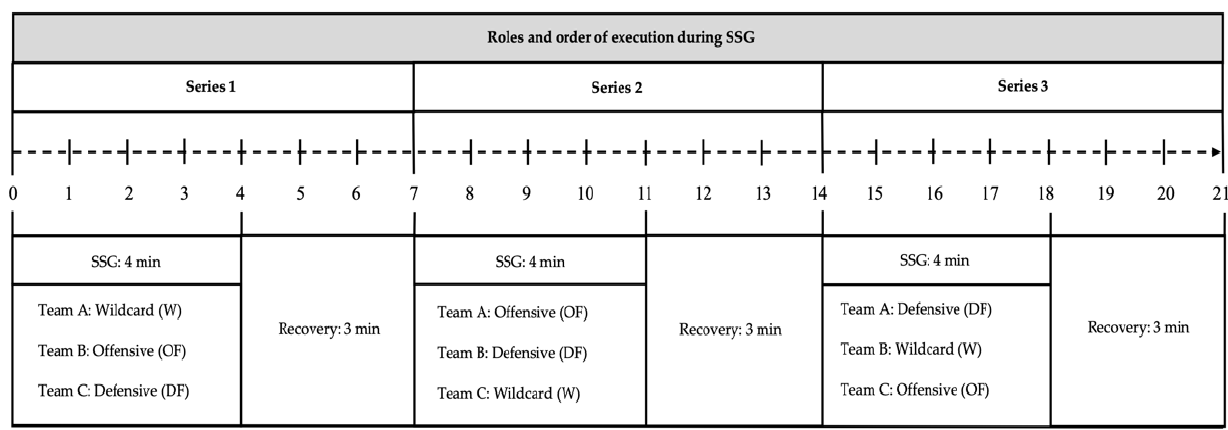
Figure 1. Roles and order of execution during the SSG.